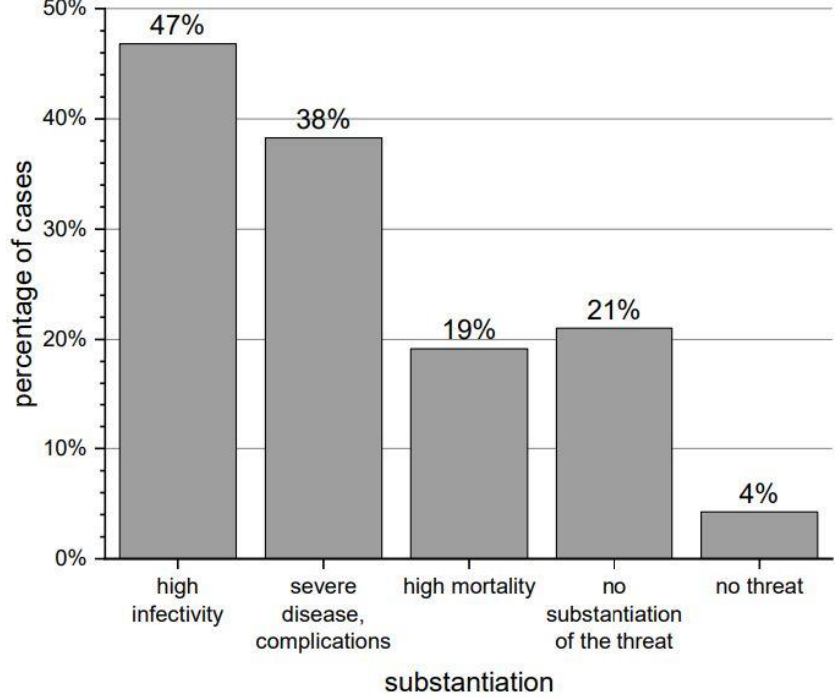
Figure 1. The most frequently quoted substantiation of why the virus is particularly dangerous. Only 6% of the respondents declared that they had not changed their behavior since the virus was identified. Out of 47 people, 46 (98% of total) followed COVID-19 protection measures. The most common measures used are presented in Figure 2.